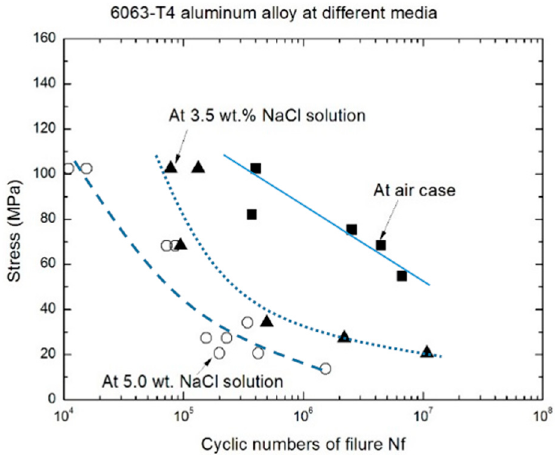
Figure 2. S ‐ N curves of AA6063 ‐ T4 in the different media at R = − 1 and f = 58 Hz. Figure 2. S-N curves of AA6063-T4 in the different media at R = ´ 1 and f = 58